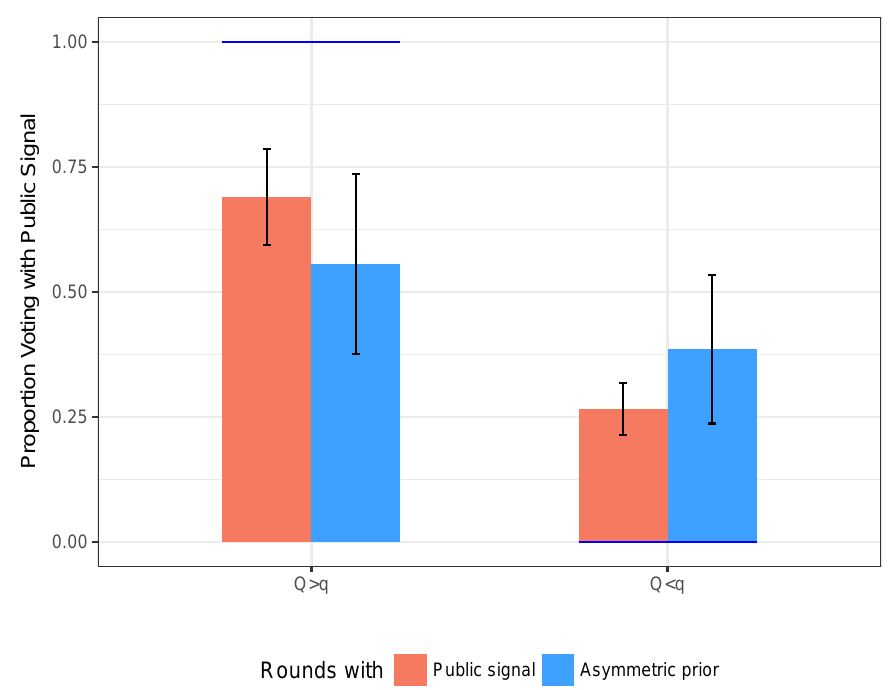
Figure A1. Asymmetric prior treatment in individual sessions. Average fraction of votes with public signal under mismatch and 95% confidence intervals. Standard errors are clustered at the individual level. The blue columns correspond to the last 10 rounds in each sessions, where the public signal content was conflated in the prior. Note: Blue lines represent the unique optimal decision in the individual treatment (follow the more precise